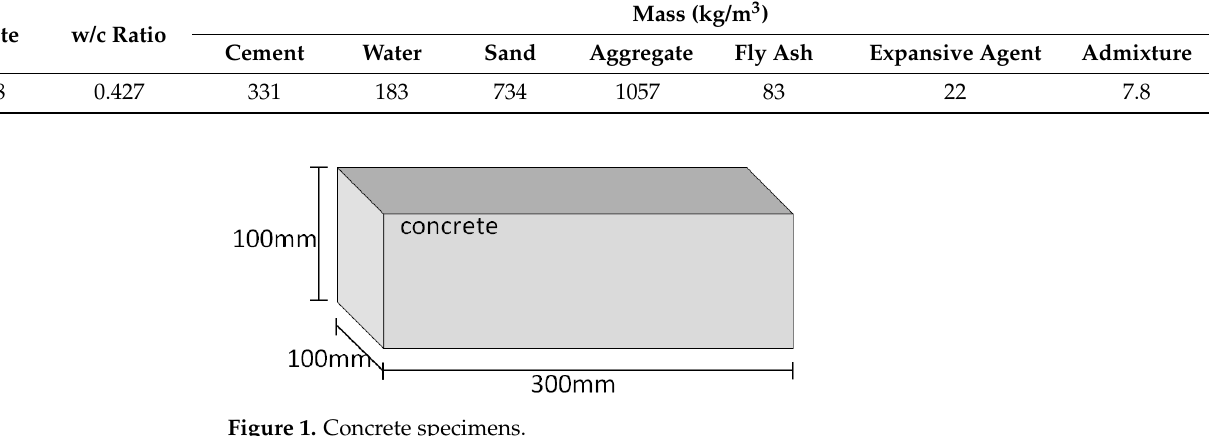
Figure 2. Heat treatment of concrete specimens. During the tests, five sections were measured, as shown in Figure 2. Five monitor ‐ ing holes were created with an interval of 5 cm, a diameter of 4 cm and a depth of 5 cm. A K ‐ type thermocouple was used to measure the temperature. Aluminum powder with high heat conductivity was poured into the monitoring holes to ensure that the thermo ‐ couple and concrete were in close contact. The maximum operating temperature and accuracy of the sheathed thermocouple were 1300 °C and ±0.75%, respectively. 2.2. Fire Test The fire test was carried out in an automatic temperature ‐ controlled muffle furnace (LYL ‐ 17LB) in the research, which was manufactured by LUOYANG LIYU KILN Co., Ltd. in Luoyang, China. The temperature in the muffle was automatically controlled by two programmable logic controllers (PLCs), with a maximum operating temperature of 1200 °C and temperature accuracy of ±0.1%, as shown in Figure 3. Figure 3. Muffle furnace and unidirectional heat transfer system.